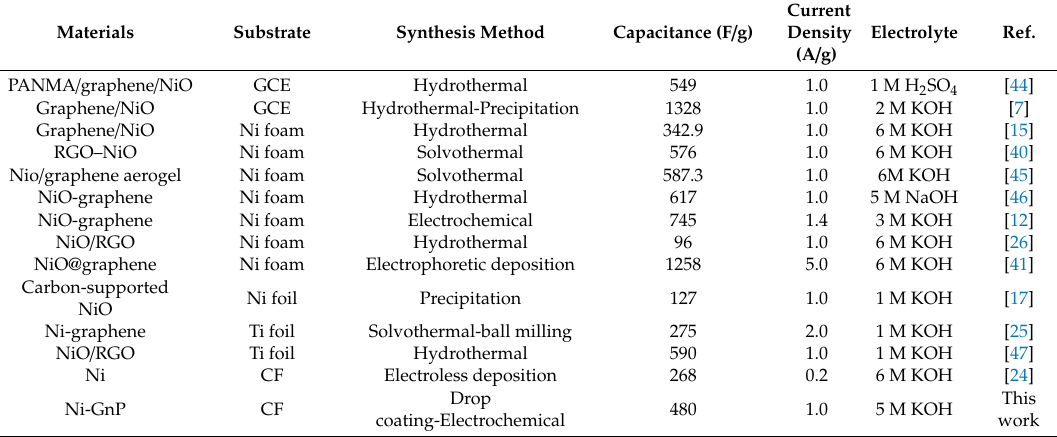
Table 1. Parameters of nickel-graphene based SCs and their electrochemical performance.